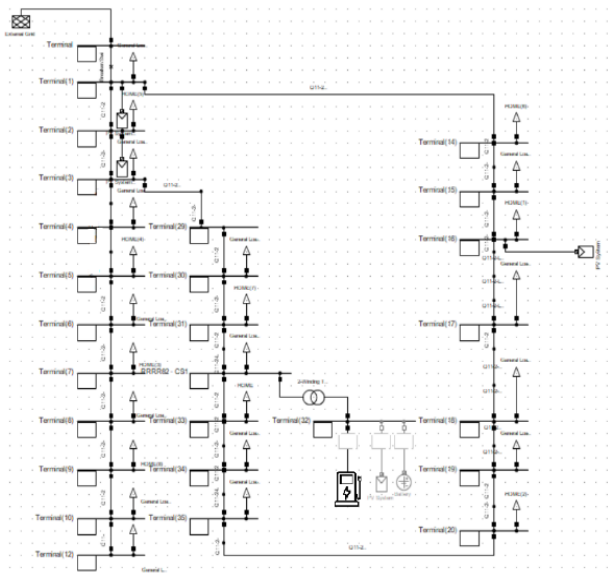
Figure 7. Urban 20 kV distribution network.